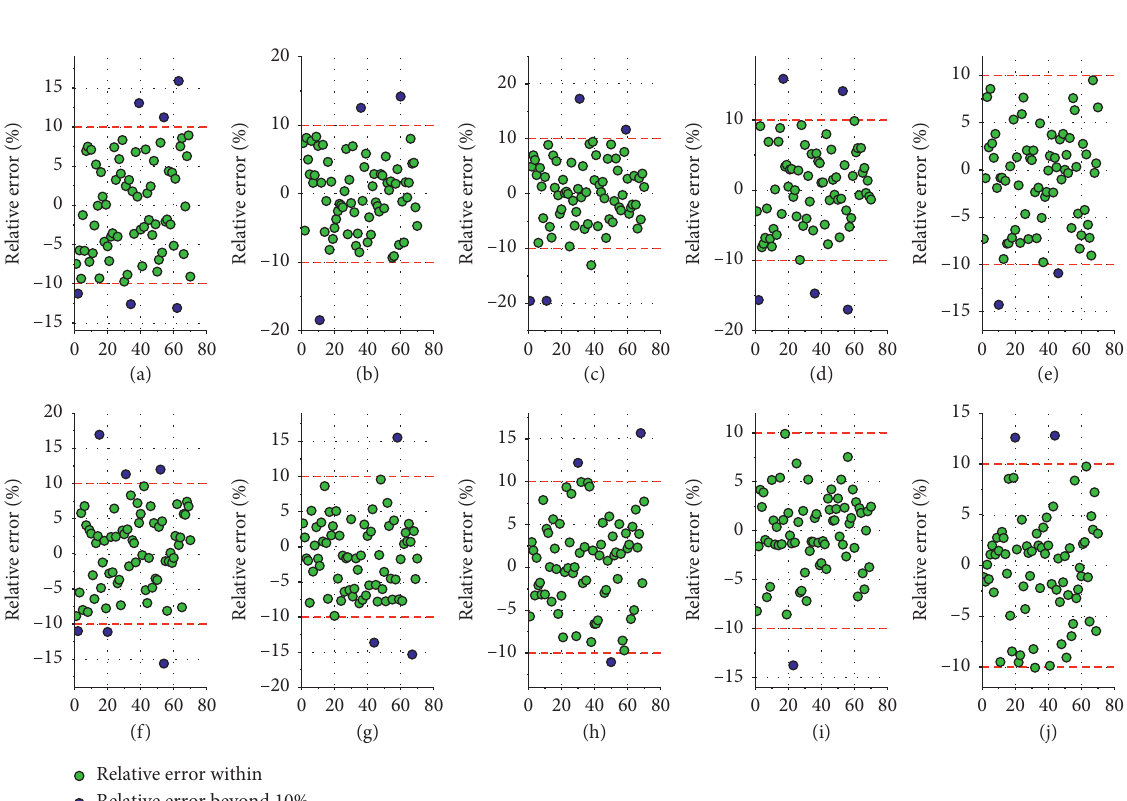
Figure 7: The relative errors between estimated and test CEV values in ten times tenfold cross-validations. The relative errors within 10% were marked green circles while beyond 10% were marked blue circles. (a) Test (1). (b) Test (2). (c) Test (3). (d) Test (4). (e) Test (5). (f) Test (6). (g) Test (7). (h) Test (8). (i) Test (9). (j) Test